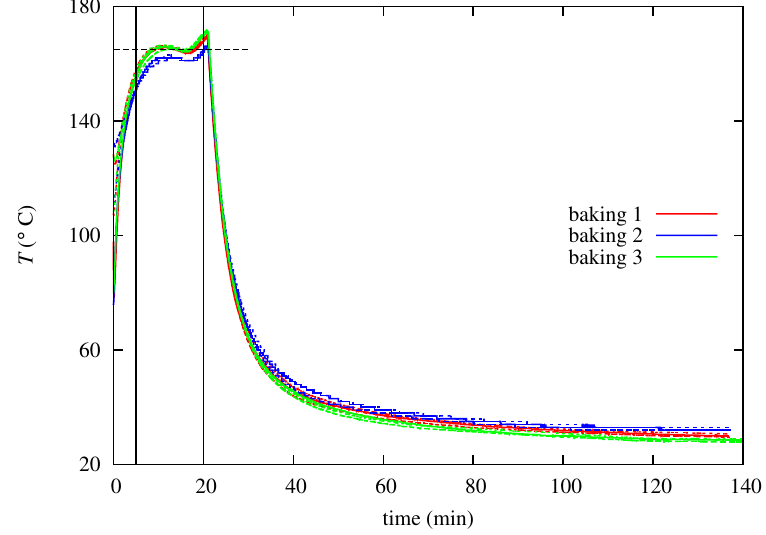
Figure 2. Temperature evolution during heating (15min at an average temperature of 165 ◦ C) and then slow cooling down to room temperature. Each colour corresponds to a batch of samples and three curves of the same colour represent the signals of the three